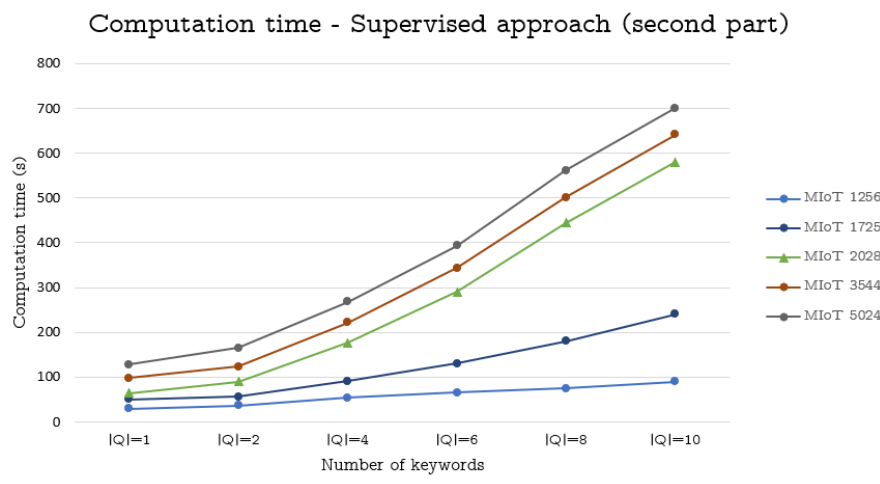
Figure 2. Computation time (in seconds) against the size of MIoTs and queries used to generate the virtual IoTs (supervised approach)—second